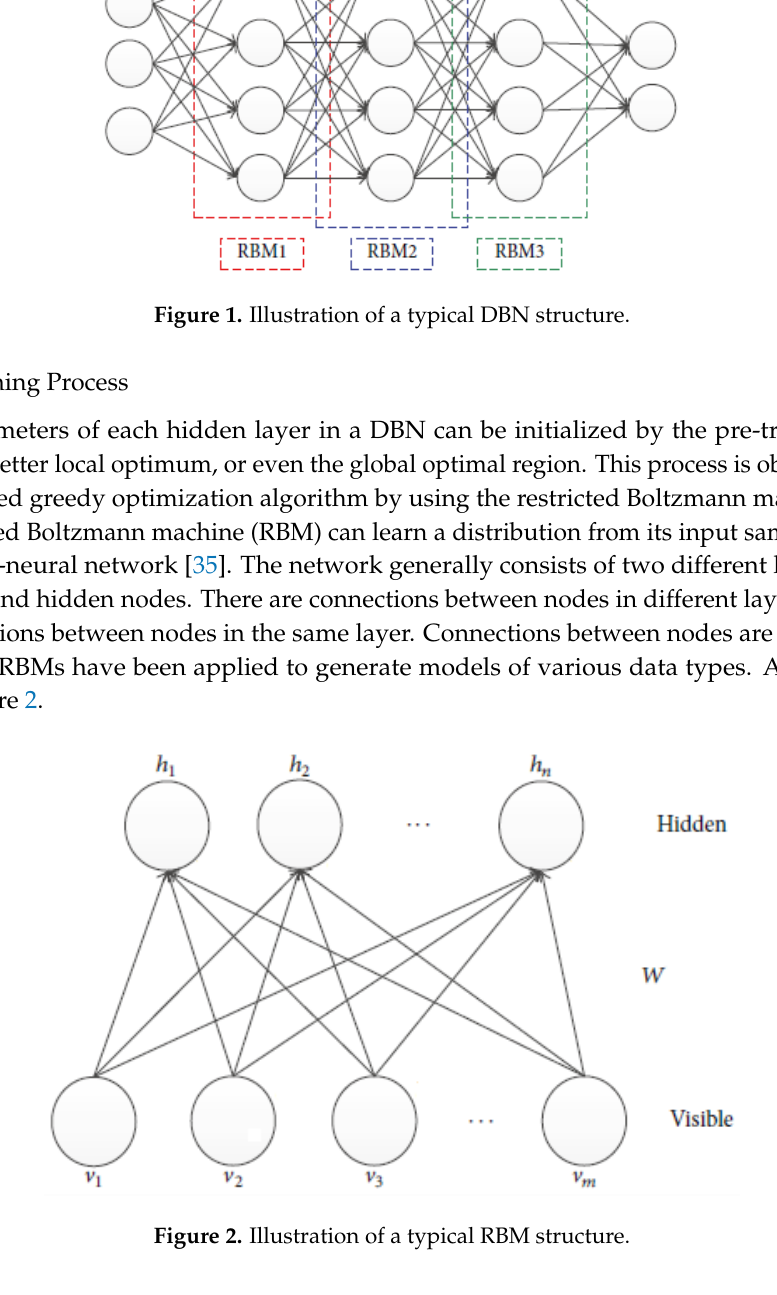
Figure 2. Illustration of a typical RBM structure.